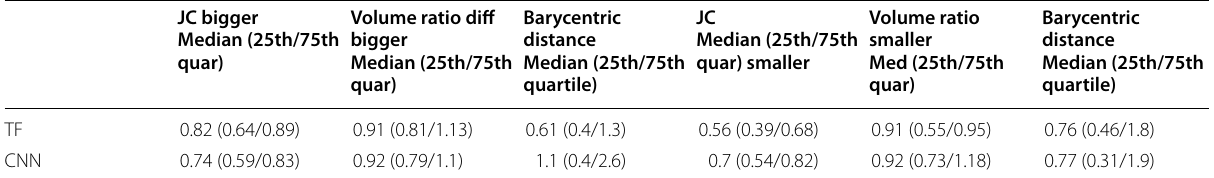
Table 2 Accuracy metrics for smaller and bigger